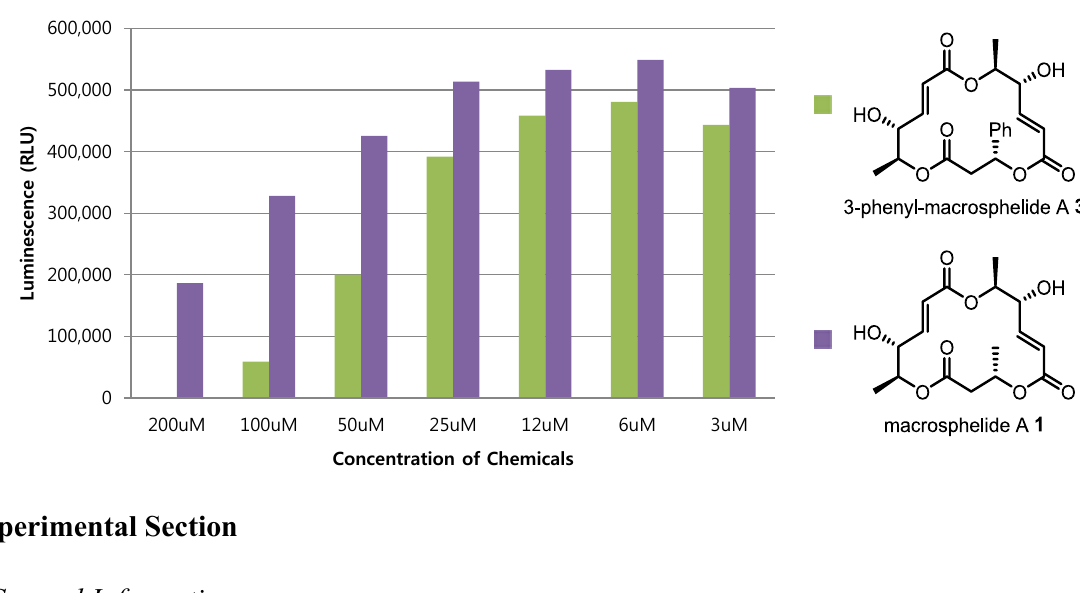
Figure 2. Anticancer activity of 1 and 3